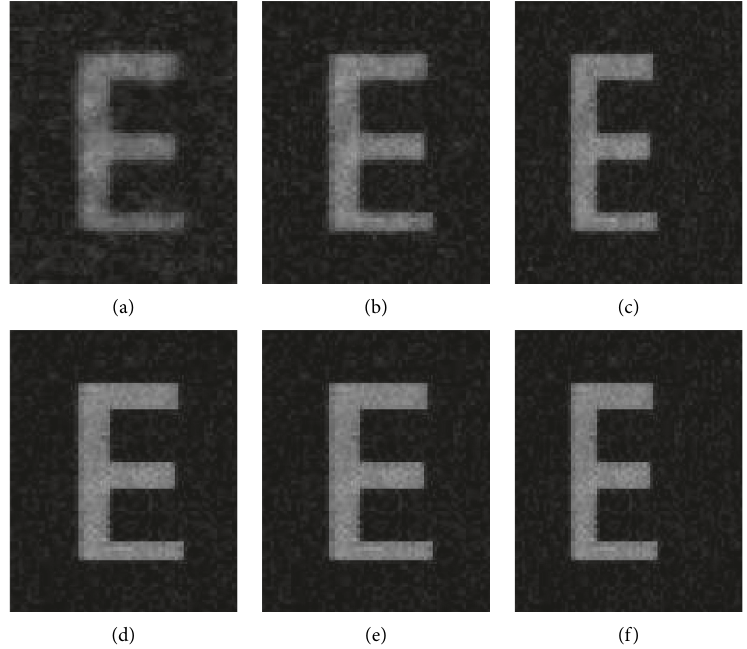
Figure 7: Intensity distribution of the decrypted 2D object using correct keys: (a) 64 × 64 × 5% measurements; (b) 64 × 64 × 10% mea- surements; (c) 64 × 64 × 15% measurements; (d) 64 × 64 × 35% measurements; (e) 64 × 64 × 45% measurements; (f) 64 × 64 × 65% measurements.